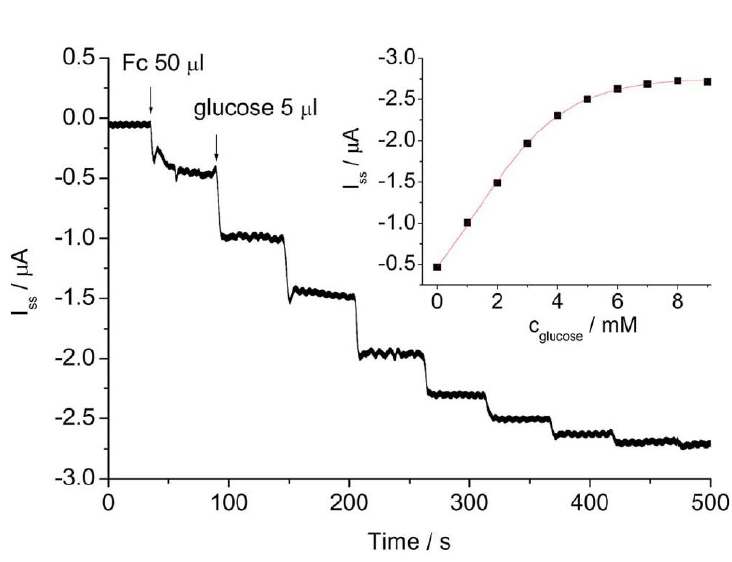
Figure 1. Amperommetric response of GOD/ZrO of 5 μL glucose to 0.1 M pH 7.0 PBS containing 0.2 mM FcPF under stirring at 0.4 V. Inset: Calibration curve. Reprinted from reference [28] with permission from